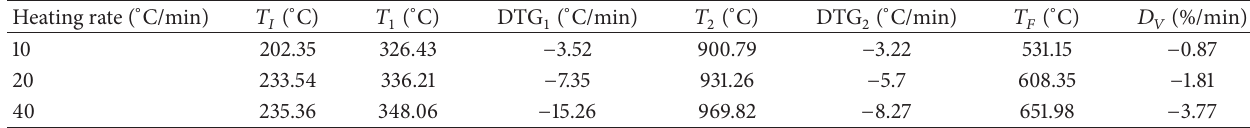
Table 4: Results from thermogravimetric analysis in CO 2 atmosphere with different heating rates.